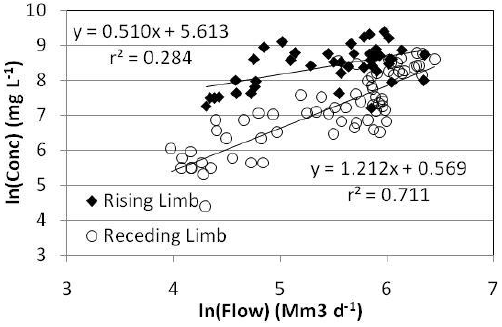
Fig. 10. Natural log of the sediment concentration vs natural log of the flow at El Diem gauge for the rising and receding limb of the discharge